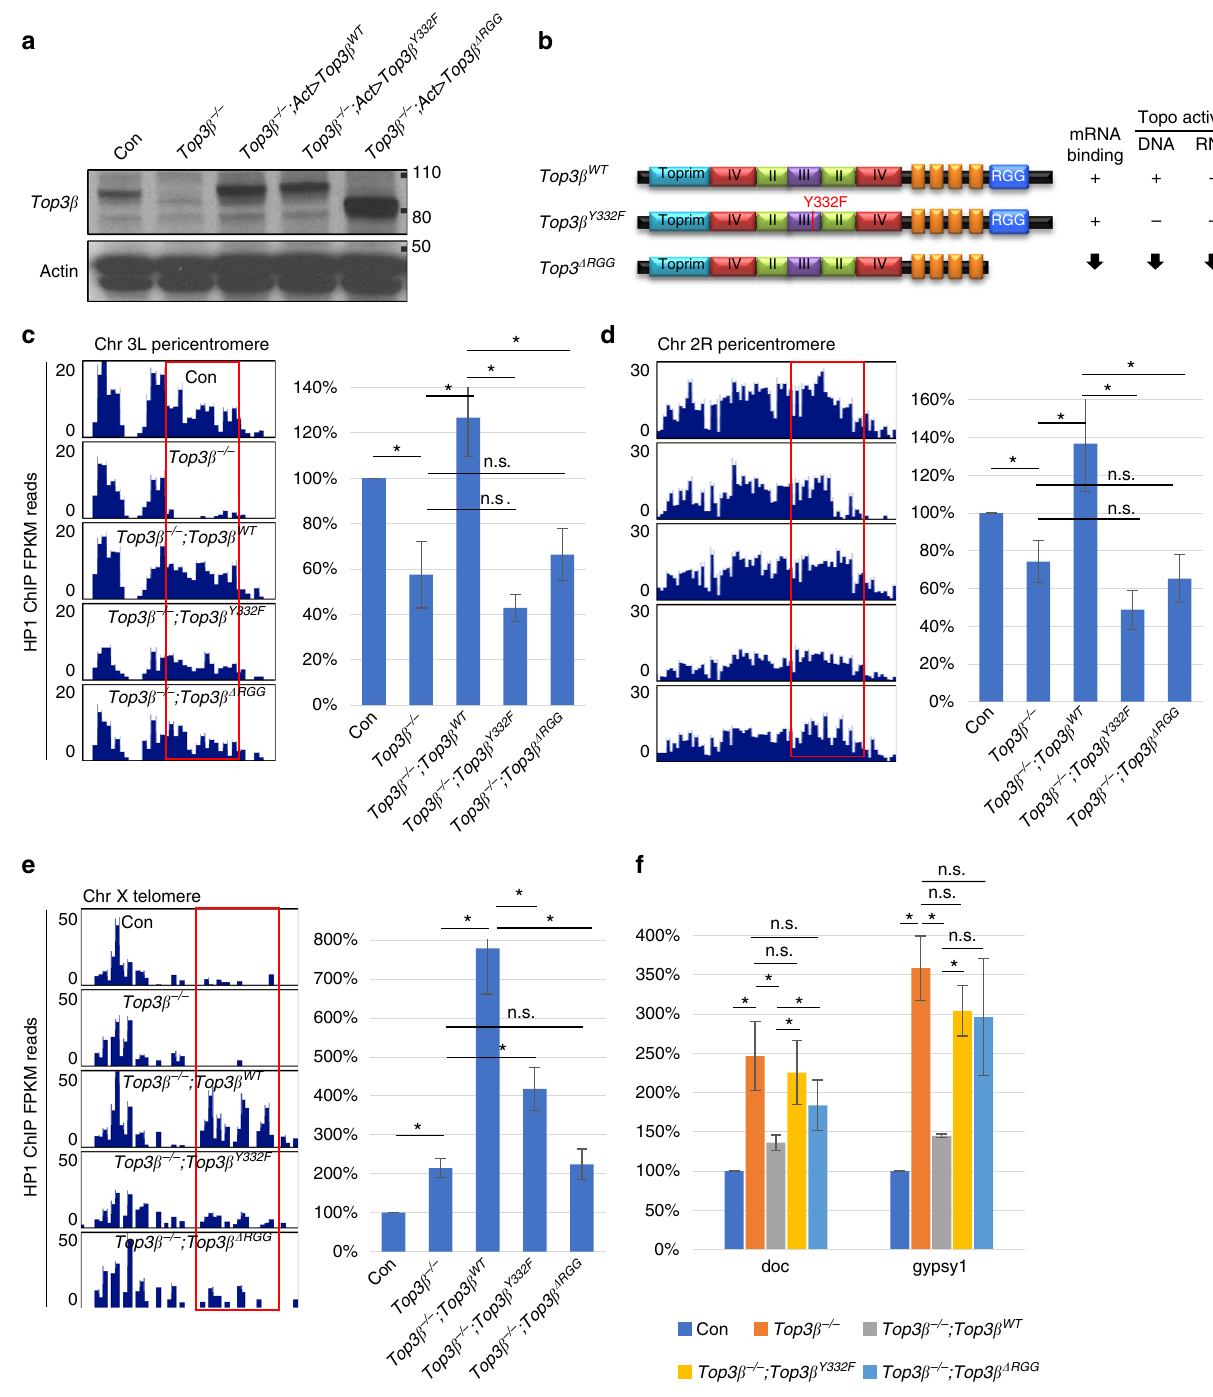
their targets by base-pairing interactions with nascent RNAs transcribed from the heterochromatin locus 37 – 39 . We predict that this process may produce RNA topological problems at some loci, which depend on Top3 β to resolve. Possibly, the nascent RNA may generate complex structures by: base-pairing with itself, or other RNAs, or DNA. These structures may prevent the nascent RNAs from being base-paired by the siRNA-loaded RISC, so they need to be resolved by the topoisomerase activity of Top3 β . How may Top3 β solve RNA topological problems during RISC-mediated heterochromatin formation? One RISC compo- nent that interacts with Top3 β is the p68 RNA helicase,